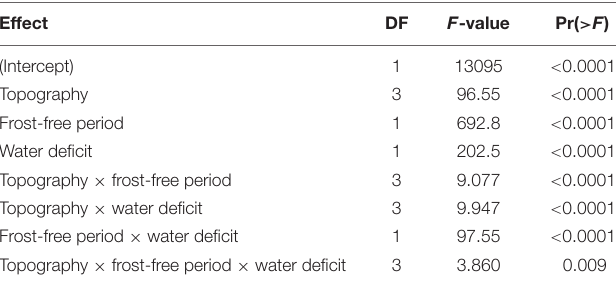
TABLE 5 | ANOVA of effects of topography and macroclimate on of proportion of cover contributed by divaricates across 9,601 plots, by Satterthwaite’s method.